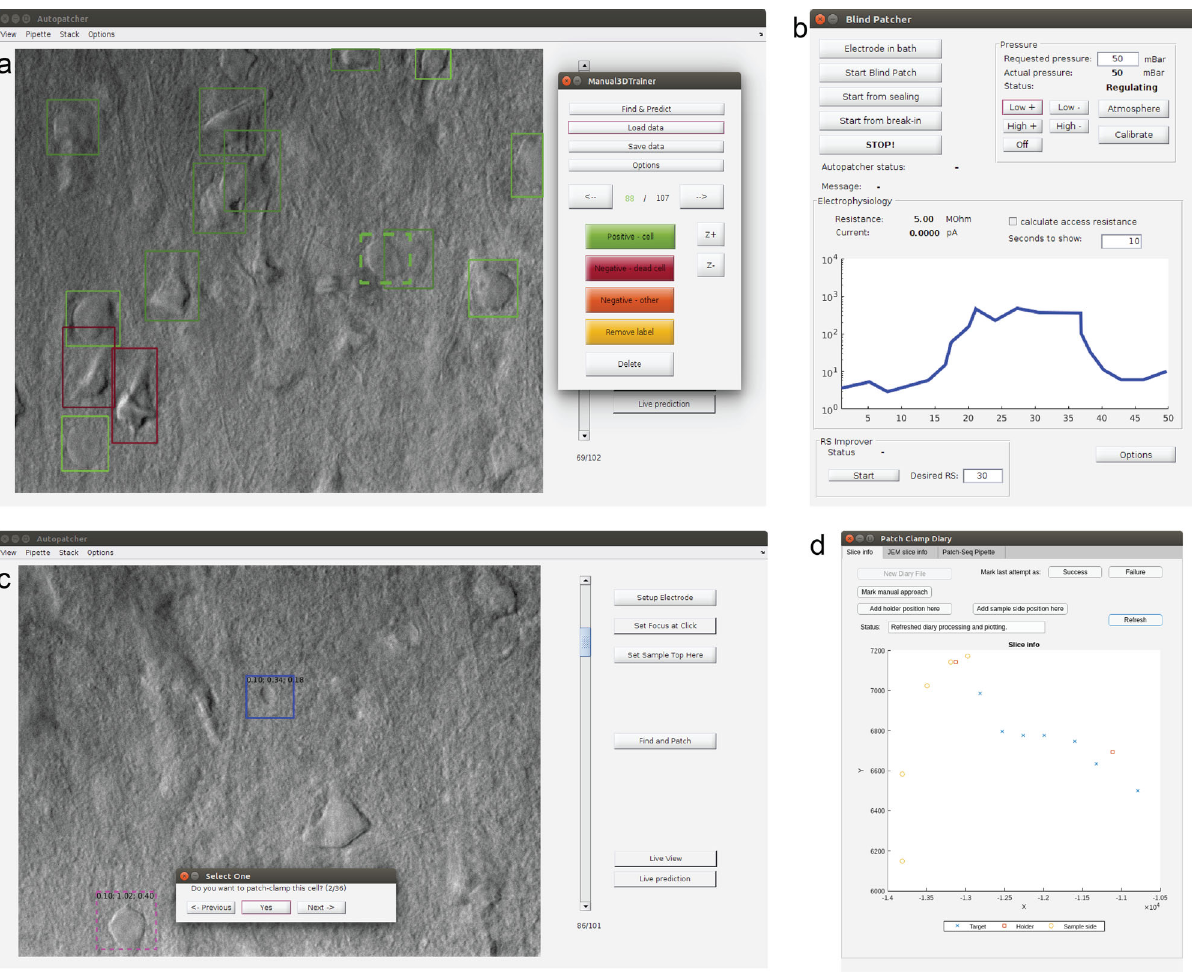
Fig. 5 GUI of the software. a Main window with an image stack loaded and the built-in labeling tool started. b Monitoring window to check the pressure and resistance values. Pressure values can be set here when operating manually, or the measurement can be restarted from different subphases here. c Main window when browsing the detected cells, initiated with the Find and Patch button. The measurement can be started by selecting a cell. d The Patch Clamp Diary module showing a plot with annotations of a sample and measurements in